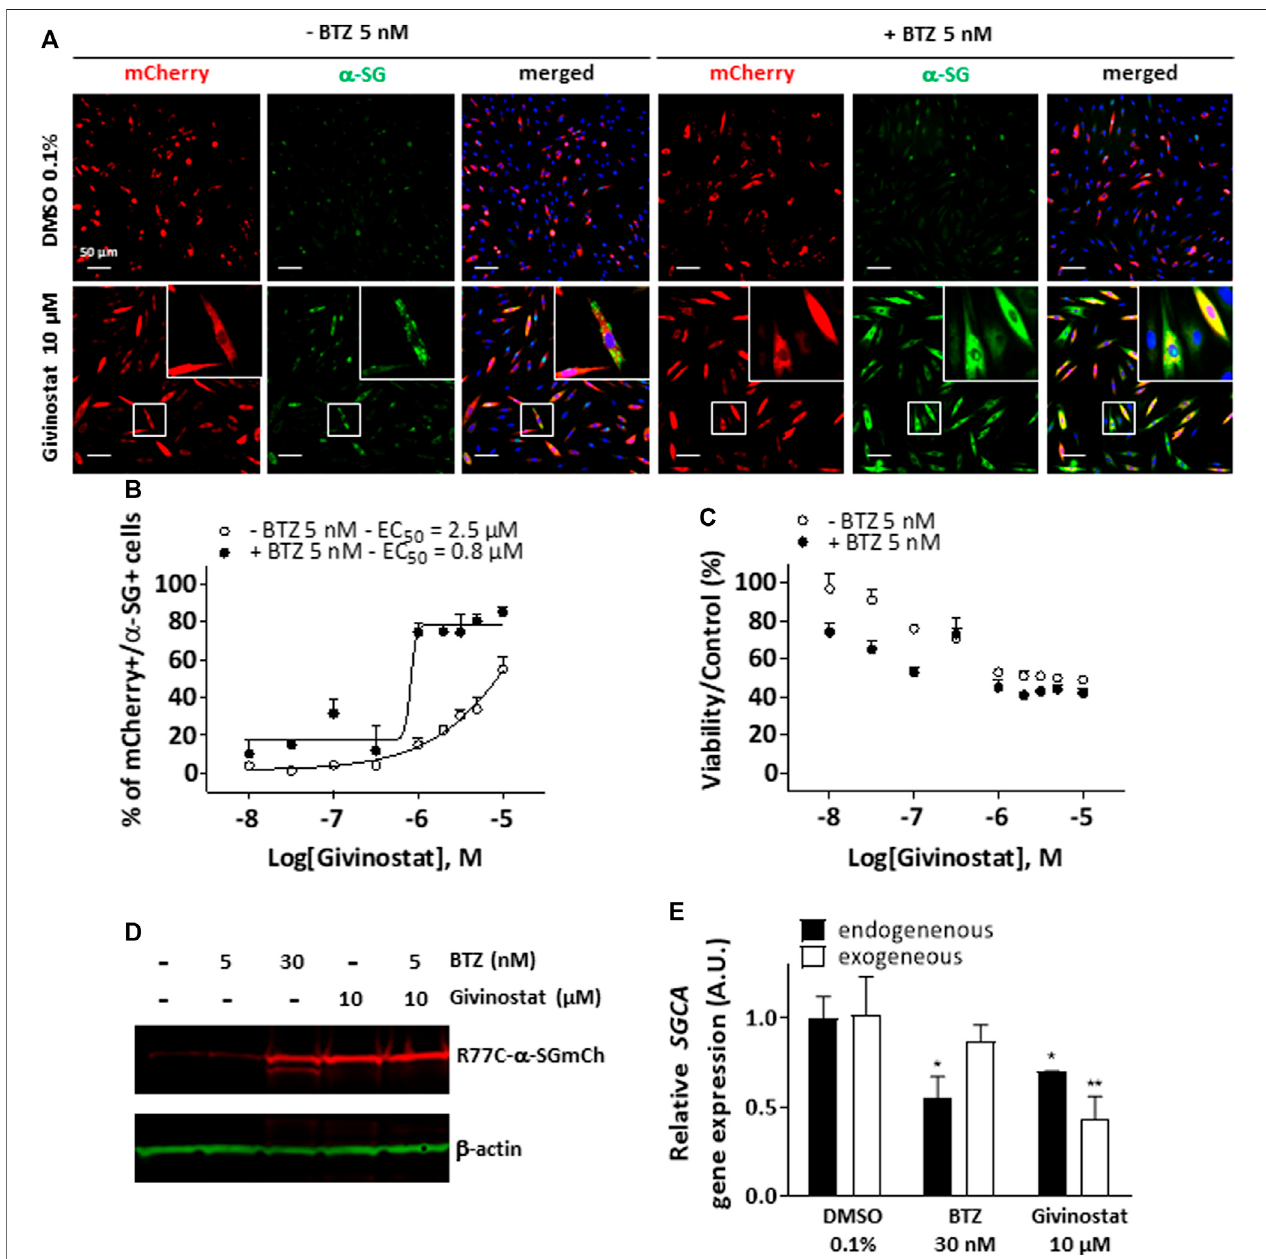
FIGURE 2 | Rescue of misfolded R77C- α -SG degradation by givinostat. (A) Images of mCherry fl uorescent signal (red) and membrane α -SG staining under non- permeabilized condition (green) in fi broblasts overexpressing R77C- α -SGmCh and treated with DMSO (0.1%), BTZ (5 nM or 30 nM) or givinostat (10 μ M or increasing concentrations) in absence or in presence of 5 nM BTZ for 24 h. Nuclei are labelled by Hoechst staining (blue). Scale bar = 50 μ m. (B,C) Quanti fi cation of mCherry and membrane α -SG positive fi broblasts (B) and cell viability (C) in fi broblasts. Each point represents the mean ± SD ( n = 4) of a representative experiment over three independent experiments. (D) Immunoblot analysis of α -SG expression after fi broblasts treatments. β -actin was a loading control. (E) Measure of endogenous and exogenous SGCA gene expression by qPCR following fi broblasts treatments. Values are expressed as relative SGCA gene expression to DMSO treated cells. Data are mean ± SD ( n = 3) of a representative experiment over three independent experiments, * p ≤ 0.05 (Student ’ s t-test). BTZ, bortezomib.